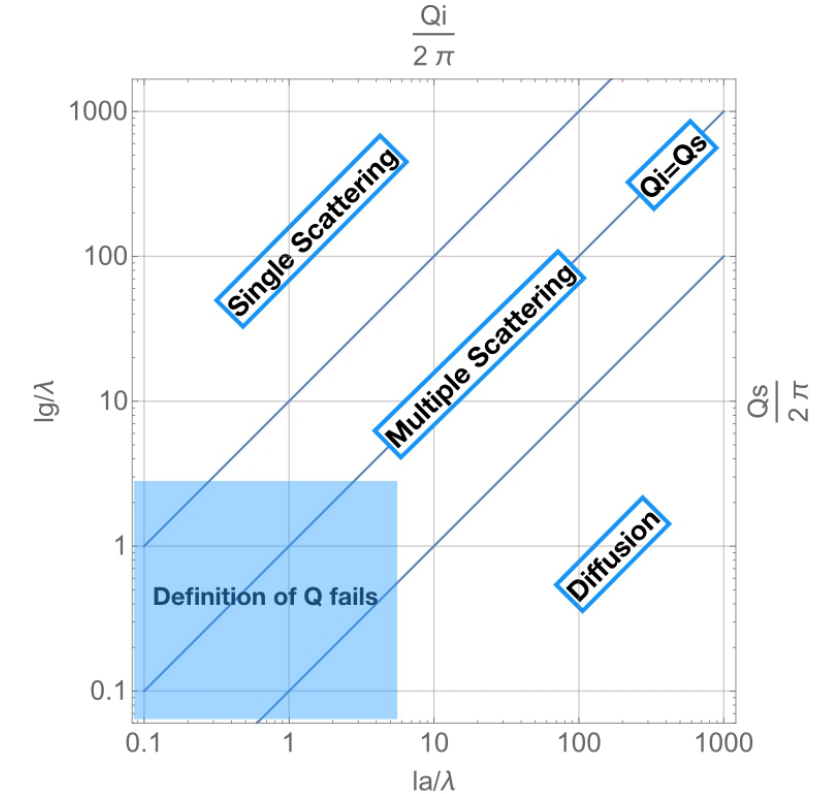
Figure 1. The units in the axes are normalized for λ , the wavelength. The blue transparent zone marks the domain in which Q definition fails. The central strip (multiple scattering) separates the zone where the “Diffusion” and “Single Scattering” regimes properly